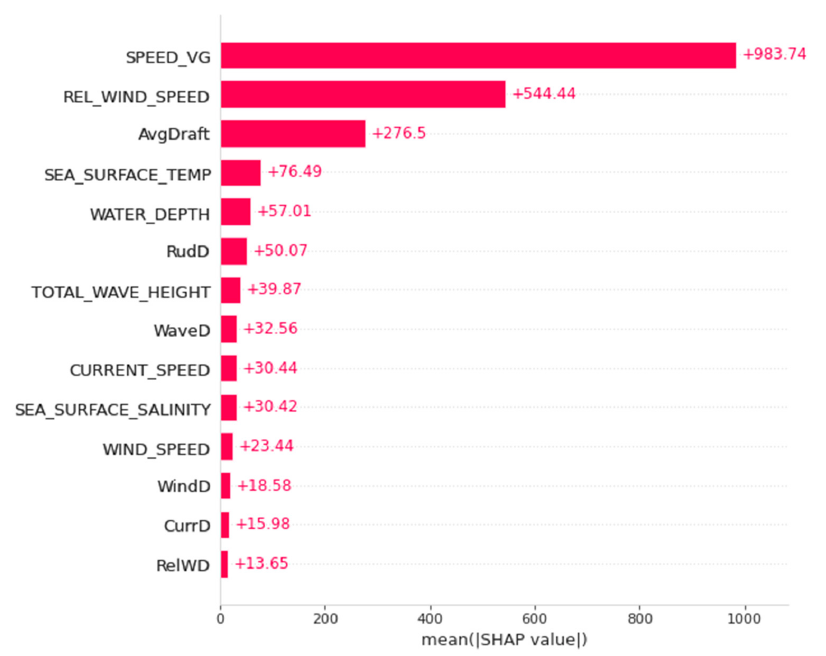
Figure 8. Mean absolute SHAP value bar plot.